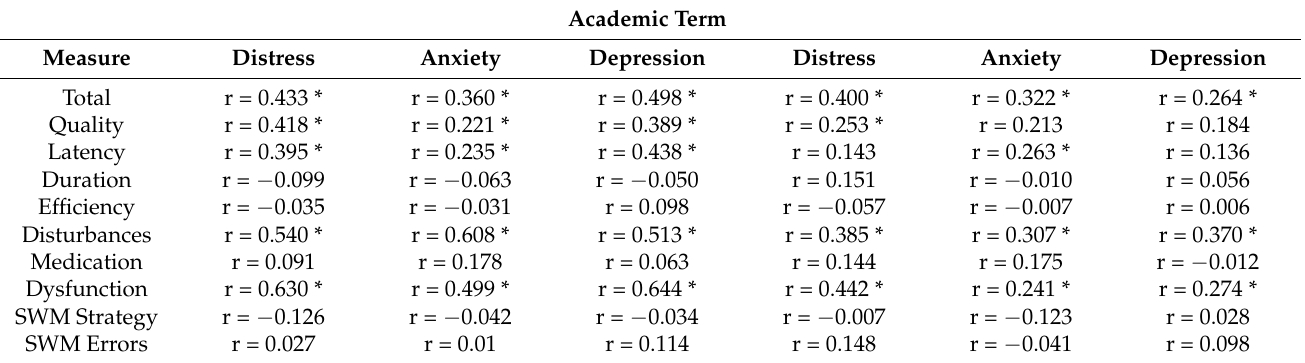
Table 4. Association between sleep quality measures and GPA in the summer period and the academic term. Terms denoted with an asterisk (*) are significant ( p < 0.05).